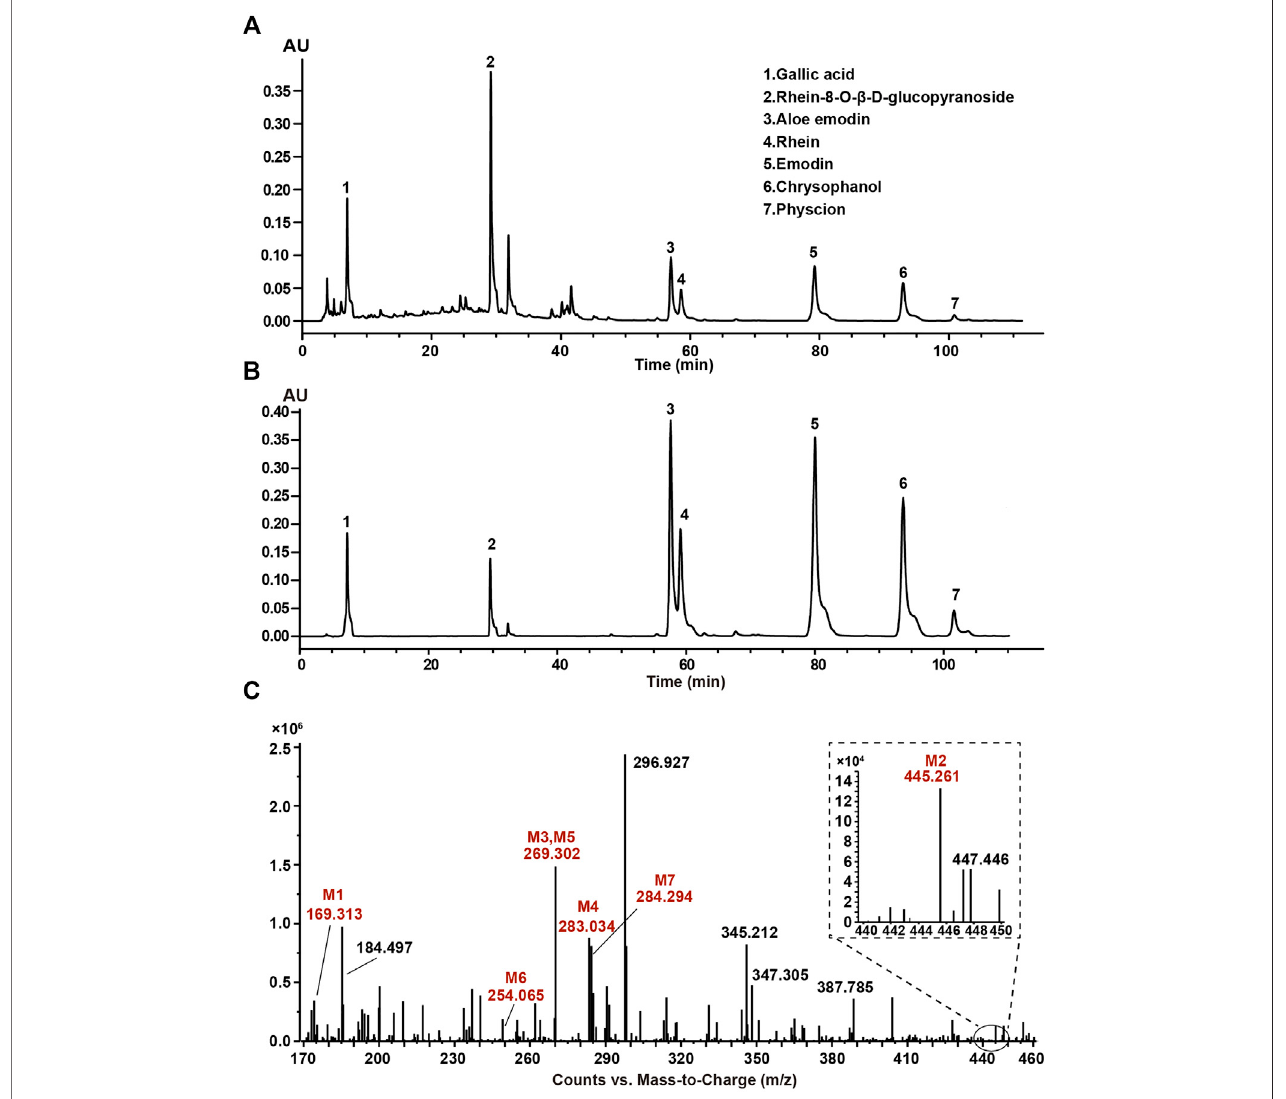
FIGURE 1 | Composition analysis of SR decoction by high-performance liquid chromatography (HPLC) and mass spectrometry. (A) HPLC analysis of SR decoction. (B) HPLC analysis of related standards. Peak 1, Gallic acid; Peak 2, Rhein-8-O- β -D-glucopyranoside; Peak 3, Aloe emodin; Peak 4, Rhein; Peak 5, Emodin; Peak 6, Chrysophanol; Peak 7, Physcion. (C) MS spectra of SR decoction by mass spectrometry. M1, Gallic acid; M2, Rhein-8-O- β -D-glucopyranoside; M3, Aloe emodin; M4, Rhein; M5, Emodin; M6, Chrysophanol; M7, Physcion.